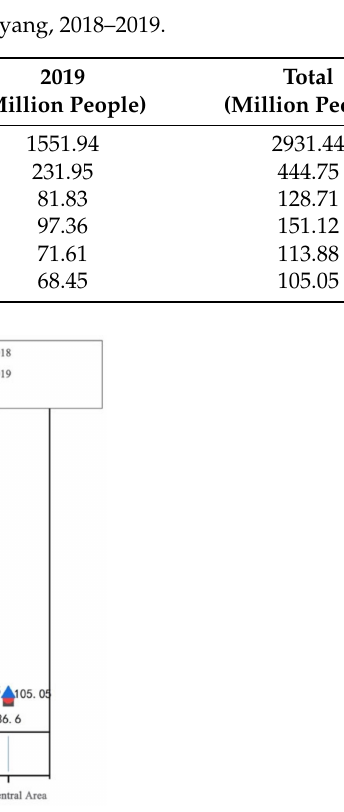
Figure 9. Annual distribution characteristics of regional tourism flows.